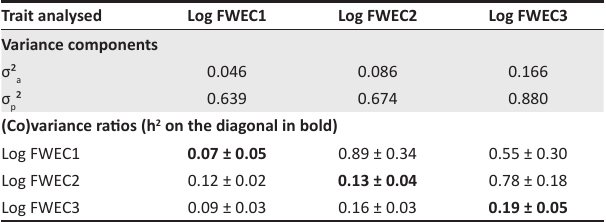
TABLE 3: Variance components and ratios (±SE) for log-transformed faecal worm egg counts estimated from the three-trait analysis with genetic (above diagonal) and phenotypic correlations (below diagonal) between expressions of faecal worm egg count in different seasons. Trait analysed Log